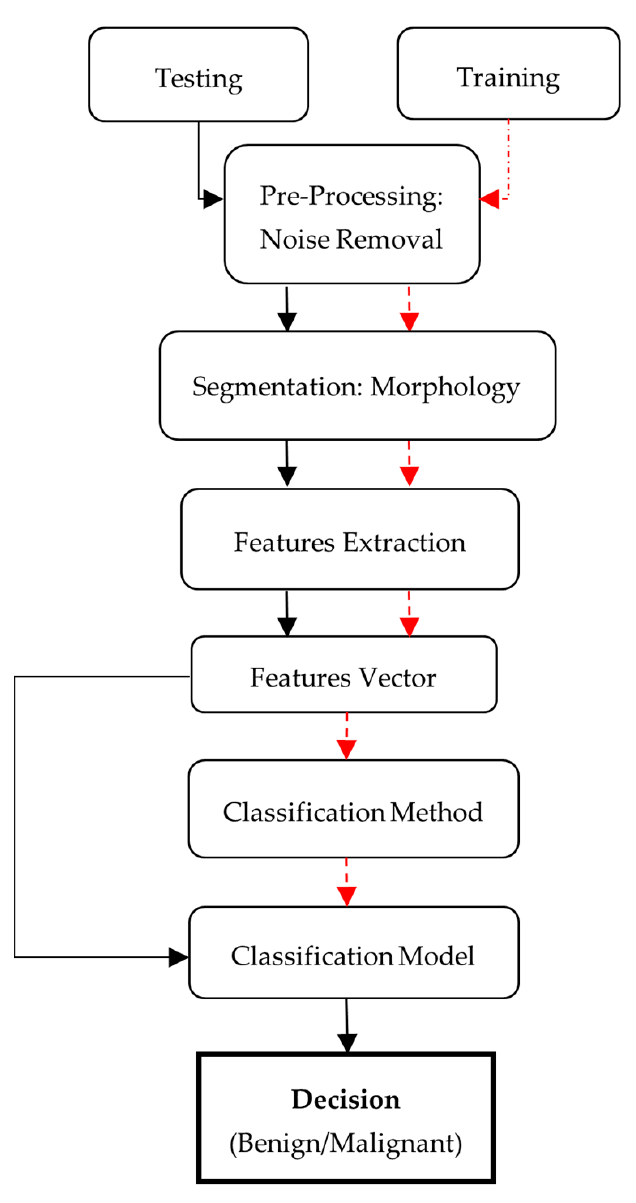
Figure 1. Proposed framework for MRI brain tumor classification.